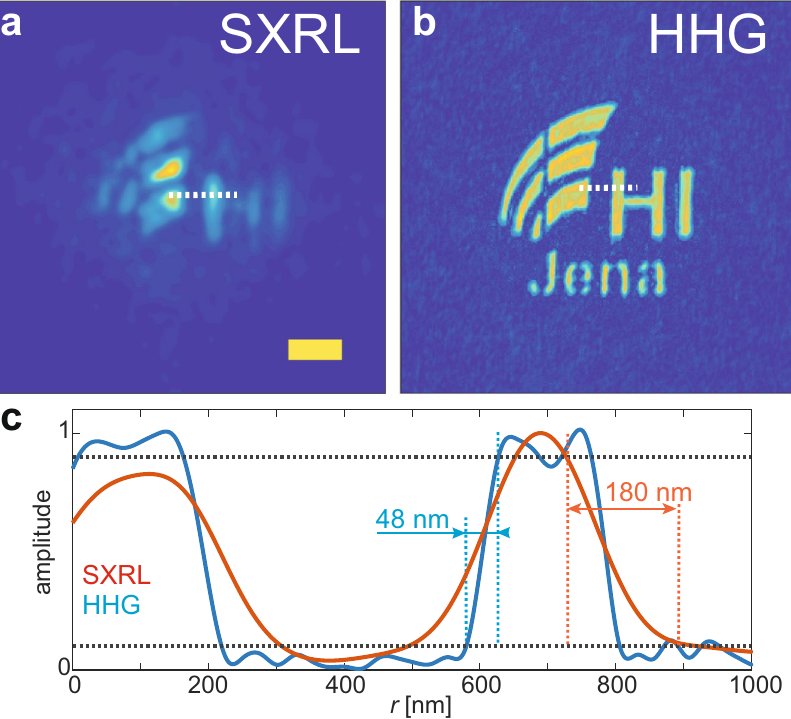
Figure 6. Comparison of imaging resolution. Panels (a) and (b) show the modulus of the reconstructed object space for the SXRL and HHG measurement, respectively. The scale bar in Panel (a) is one micron for both panels. ( c ) The achieved resolution for HHG-CDI is 48 nm (blue line) and approximately 180 nm for the SXRL- CDI measurement (red line). The line profiles were taken at the position of the dotted white line in Panels (a) and (b),